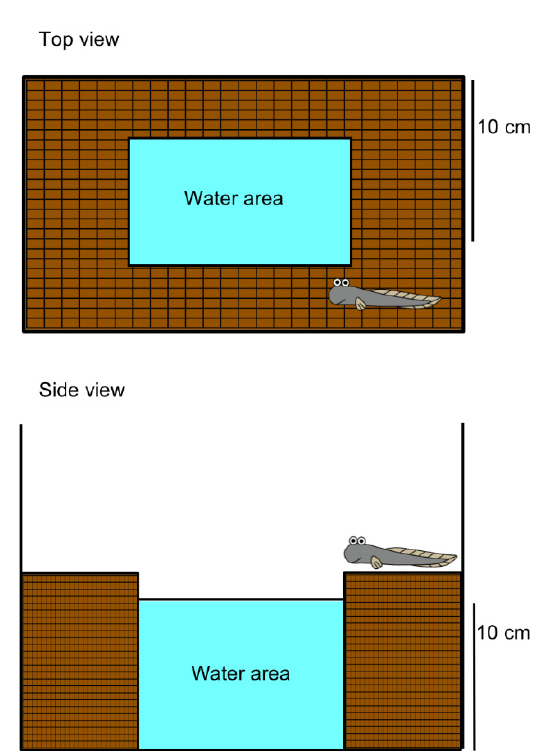
Figure 2. Schematic of the experimental setup used to examine amphibious behavior in mudskippers. The hashed area represents land and is easily accessible to the mudskipper placed in the water area. Treatment with stressors and hormones allows the observation of the period of time in water and the frequency of migration. Plastic mesh on the land area facilitates drainage of water. Water in the tank is constantly aerated [17,24–26].